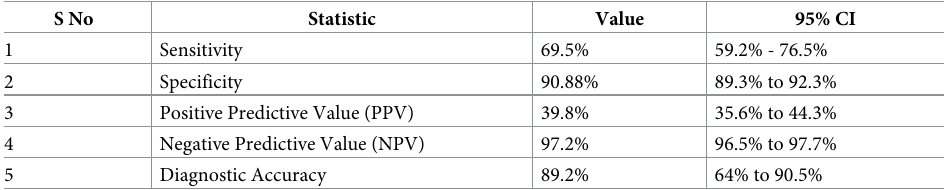
Table 2. Showing statistical analysis of study